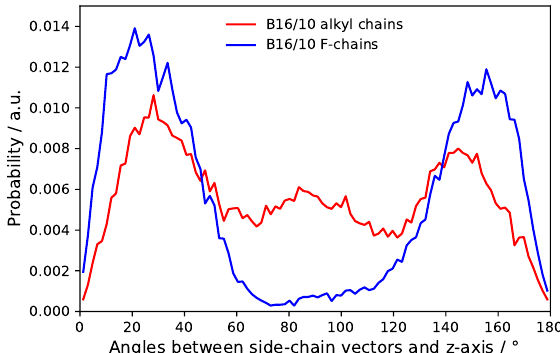
Figure 10. Probability distribution of side chains